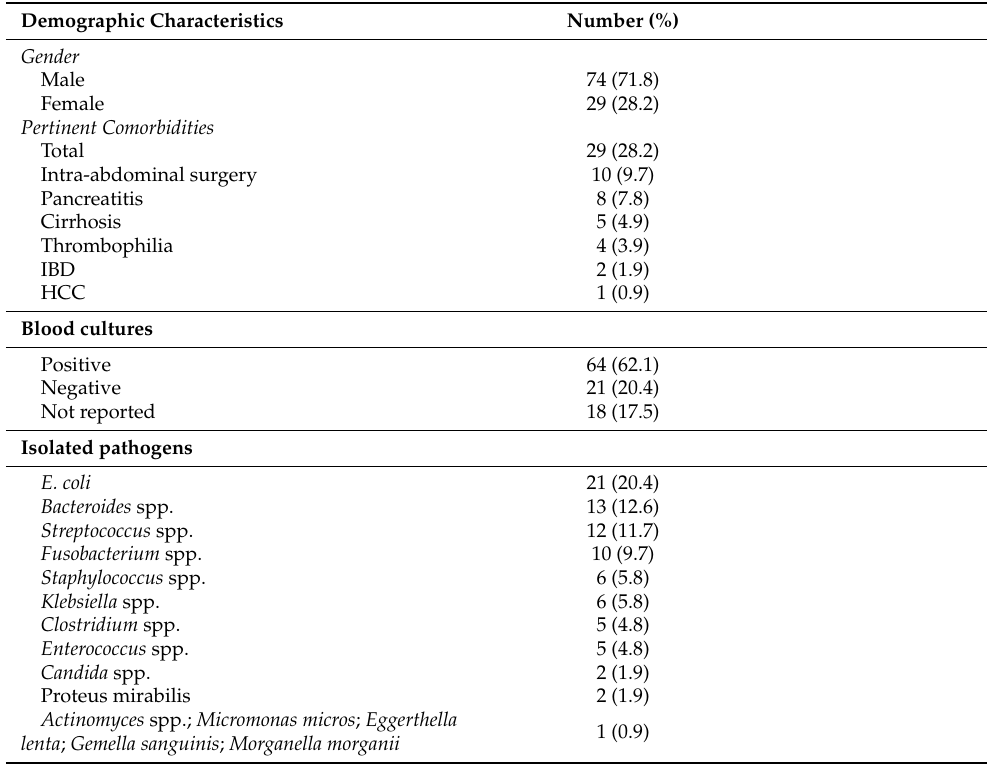
Table 1. Demographic data, blood cultures, signs and symptoms, treatments, and outcomes for patients